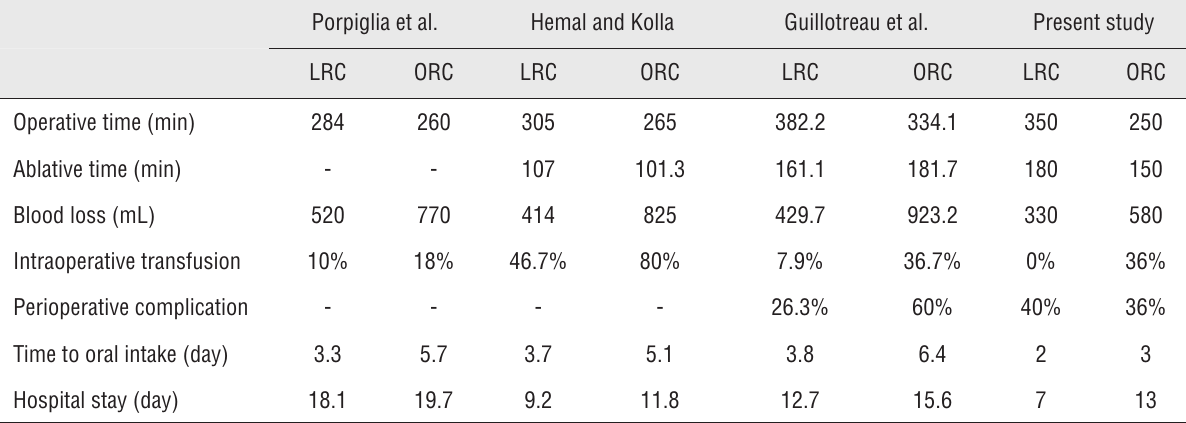
Table 3 - Comparison of perioperative characteristics. Porpiglia et al. Hemal and Kolla Guillotreau et